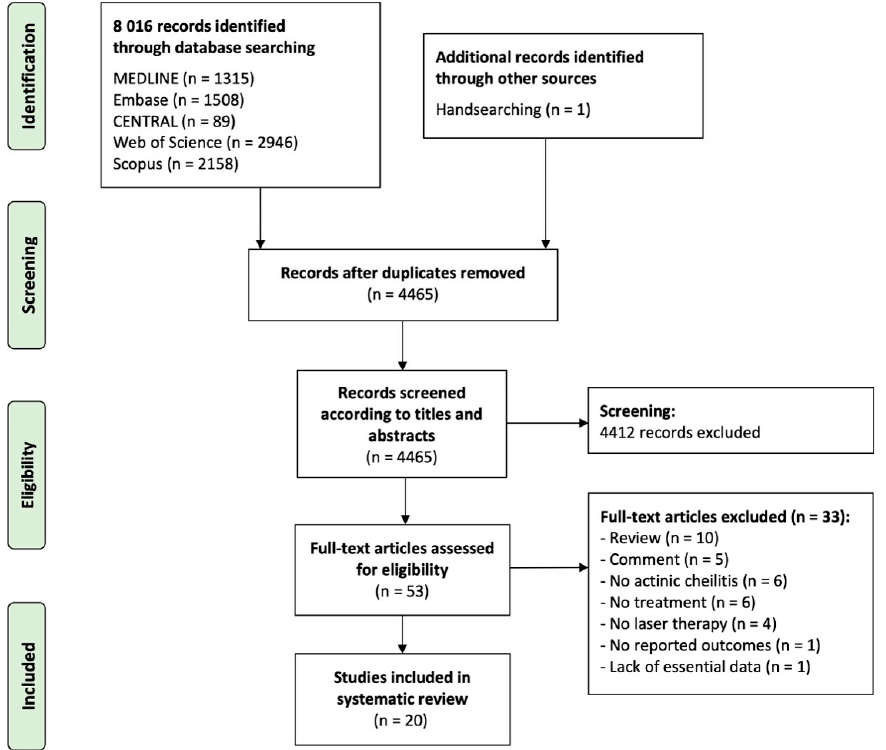
Figure 3. Flow diagram showing the identification and selection process of primary-level studies in this systematic review, analyzing the clinical implications of laser therapy in patients suffering from actinic cheilitis.